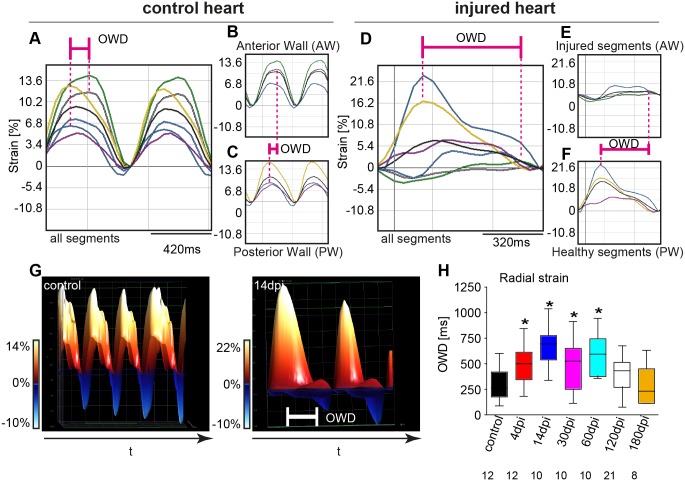
Time-to-peak and maximal opposing wall delay analysis reveals considerable asynchronicity of injured to non-injured ventricular wall.Segmental strain traces recorded from Sham. (A-C) and cryoinjured, regenerating hearts at 14dpi (D-F) are shown. (A) Representative segmental strain traces of non-injured hearts exhibit only minor time-to-peak delay between opposing ventricular wall segments (OWD) as illustrated by the pink line. (For color-coding explanation see Fig 2B.) (B-C) Individual strain curves of anterior (B) and posterior wall segments (C). (D) Representative segmental strain curves derived from a regenerating heart at 14dpi demonstrating considerable OWD intervals. (E-F) Individual strain curves of injured anterior (E) and non-injured posterior wall segments (F). For each image displayed, the black line indicates the average curve. (G) 3D-reconstruction of regional strain analysis derived from a control (left) and injured (right) heart at 14dpi with the frontal view rotated 90° counterclockwise. Every peak represents consecutive systoles. The anterior wall (AW) is located in the front, while the posterior wall (PW) is situated in the back. In the control presentation (left) the AW and PW peaks are completely overlapping, presenting absolute synchronicity. However, at 14dpi (right) the residual AW activity is visible as a small peak offset to the right of the PW peak in the back. This offset represents the OWD. (H) Quantitative analysis of mean OWDs at depicted time points. Small numbers indicate number of animals measured. Values are expressed as mean ± SEM; *, p<0.05, unpaired student’s t-test and ANOVA with post hoc comparisons by Bonferroni’s multiple comparison test.